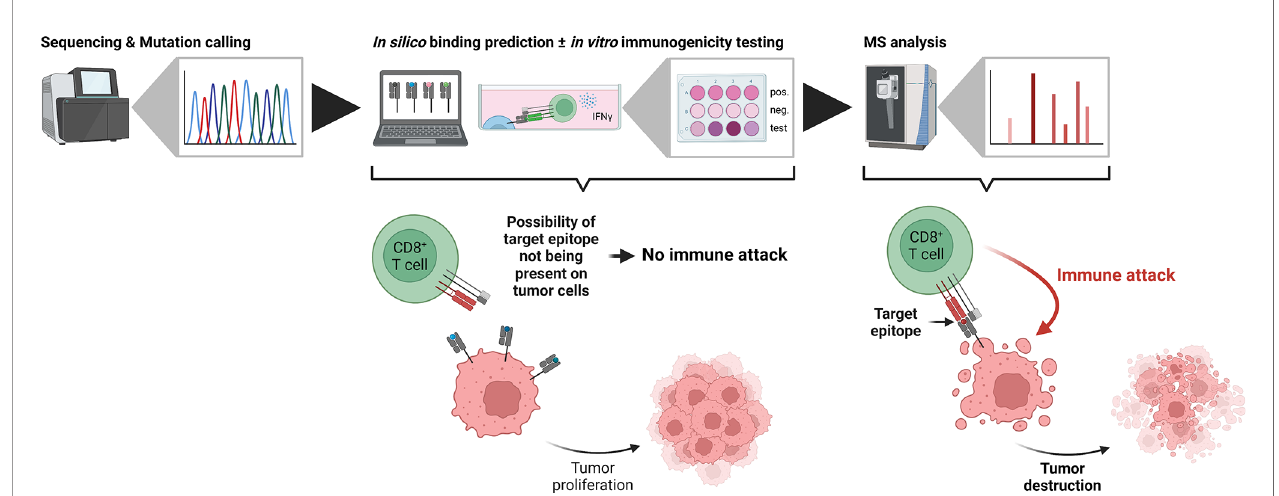
FIGURE 2 | The importance of being presented. In typical neoantigen identi fi cation work fl ows, candidate tumor antigens are de fi ned from next generation sequencing data (left side). Subsequent in silico binding predictions and in vitro immunogenicity tests identify potential tumor neoepitopes, which, however, are not necessarily presented on the tumor cells themselves. If the target epitope is not present, CD8 + T cells cannot identify the transformed cells and the tumor proliferates (middle). In contrast, mass spectrometry-based immunopeptidomics identi fi es truly presented and actionable epitopes. Immunotherapies targeting these epitopes lead to an immune attack by CD8 + T cells and tumor destruction (right side). Created with